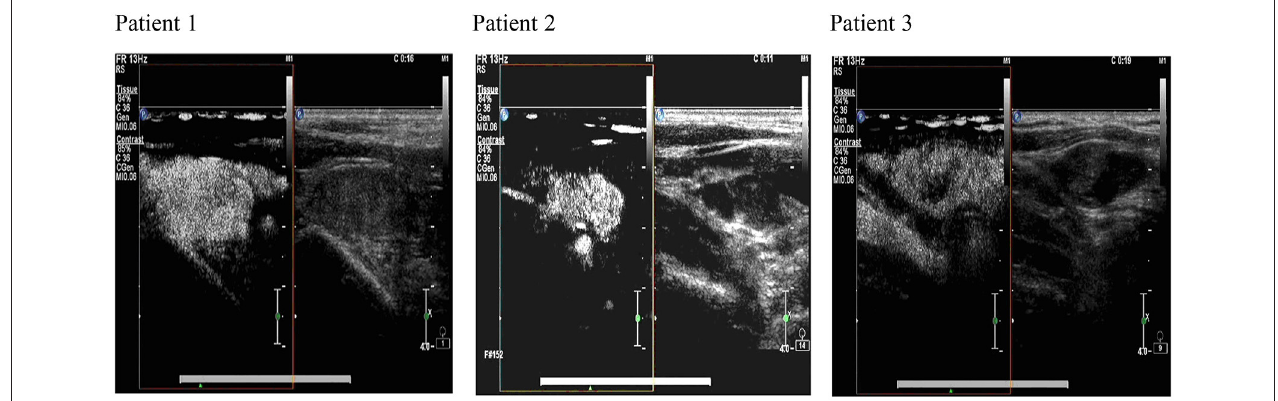
FIGURE 1 | The ultrasonography image of cervical lymph nodes in comparison with ultrasound contrast and color ultrasound images. The images produced by color ultrasound are used for the evaluation of the nature of lymph node lesions. The characteristics of “uneven enhancement” and “fast forward and slow backward” are observed after ultrasound contrast. Postoperative pathological analysis confirms lymph node